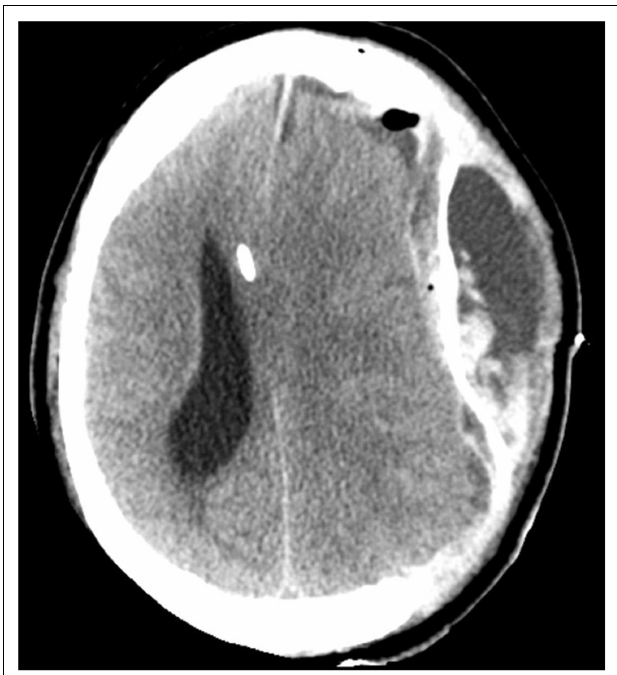
FIGURE 4 | CT on day 11, 4days post a left-sided hemicraniectomy. An EVD catheter in situ in the right hemisphere.There is a left-sided epidural expansive mass adjacent to the duraplasty (artificial membrane) causing a severe